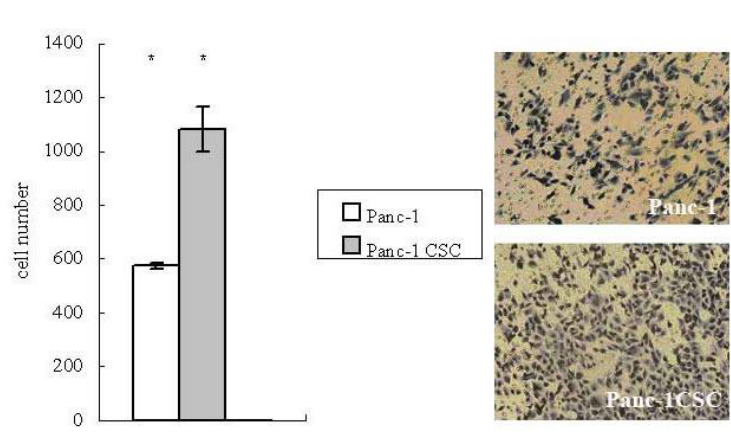
Figure 3. Panc-1 CSCs have increased migration ability. The migration of Panc-1 CSCs or Panc-1 cells was determined by transwell migration assay. After the filter was fixed and stained, the number of cells migrated to the undersurface of the filter was compared. Left side: Panc-1 CSCs had increased migration ability compared to Panc-1 cells, (40× fold). * p < 0.05. Right side: images of Panc-1 cells (top) and Panc-1 CSCs (bottom).